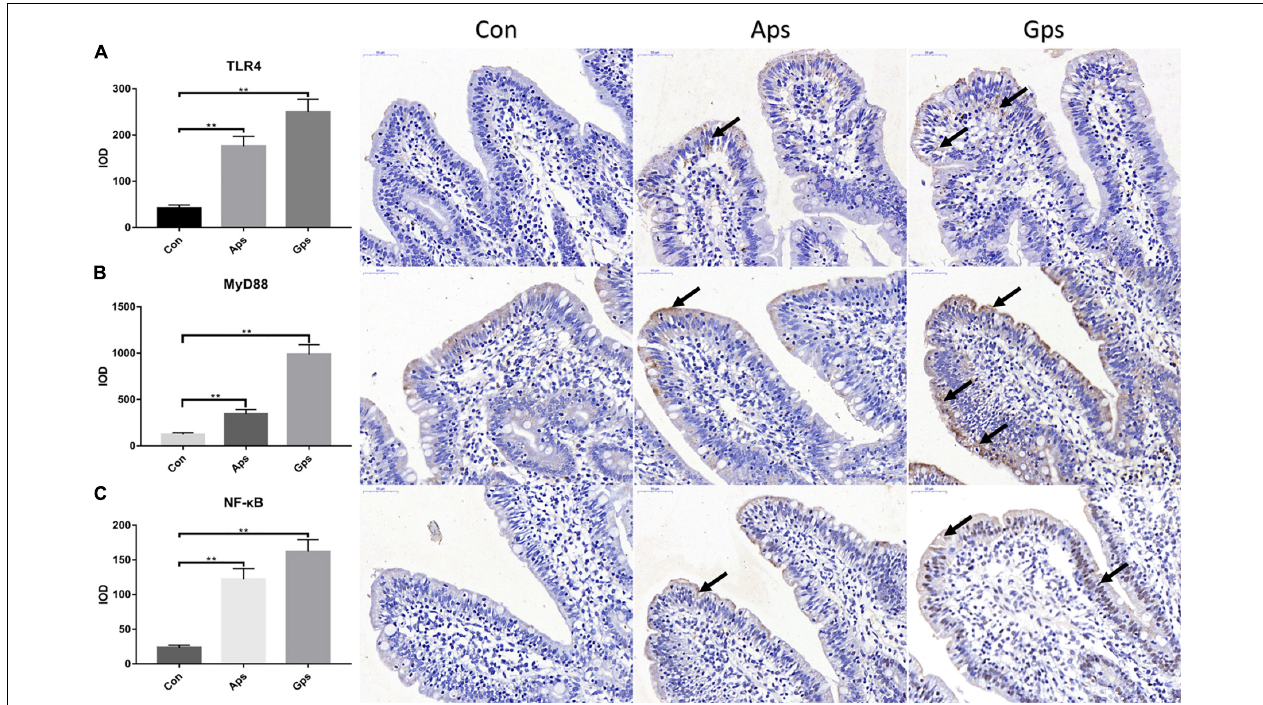
FIGURE 4 | Effect of the Aps and Gps on the protein expression about TLR4 signaling pathways in jejunum of weaned piglets. A represents Immunohistochemical results of TLR4; B represents Immunohistochemical results of MyD88; C represents Immunohistochemical results of NF- κ B. Con represents the control piglets; Aps represents the piglets supplemented with the astragalus polysaccharide; Gps represents the piglets supplemented with ginseng polysaccharide. Shooting multiples: 400 × . ∗∗ Means significant difference ( P < 0.01). Values means n = 6 for the analysis of jejunal